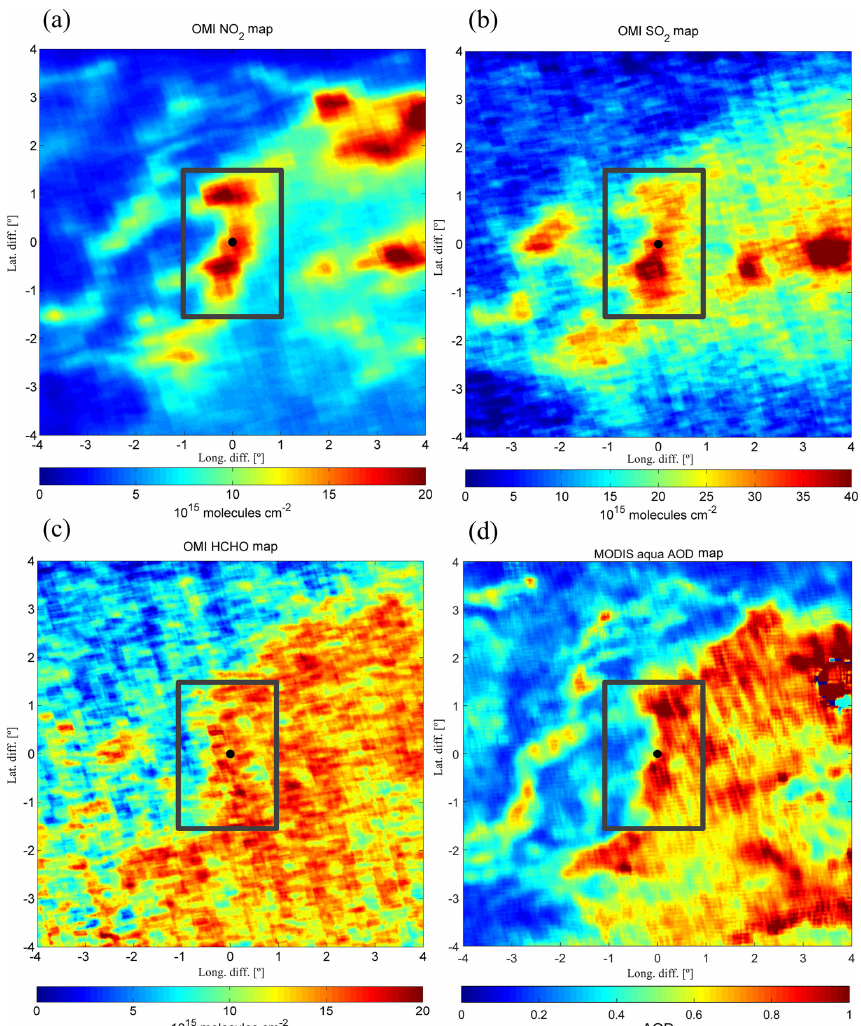
Figure 2. Maps of average tropospheric VCDs of (a) NO 2 from DOMINO v2 (Boersma et al., 2007, 2011), (b) SO 2 (Theys et al., 2015) and (c) HCHO (De Smedt et al., 2008, 2012, 2015) from BIRA-IASB, derived from OMI observations. Average AODs derived from the MODIS AQUA instrument are shown in (d) . The maps show the same area over Eastern China as shown in Fig. 1a. Data are averaged for May and June of all years from 2012 to 2016. The black dots indicate the measurement station. The grey squares mark the same area as shown in Fig.